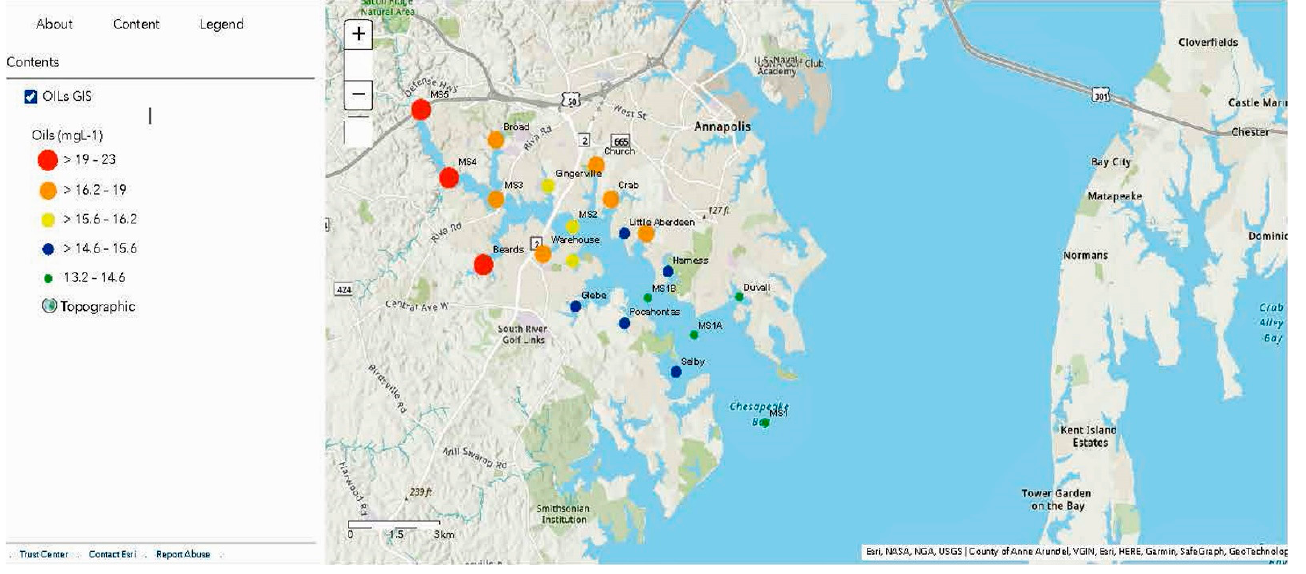
Figure 9. GIS map of surficial oil concentration in the main stem and corresponding triblets of the South River estuary.